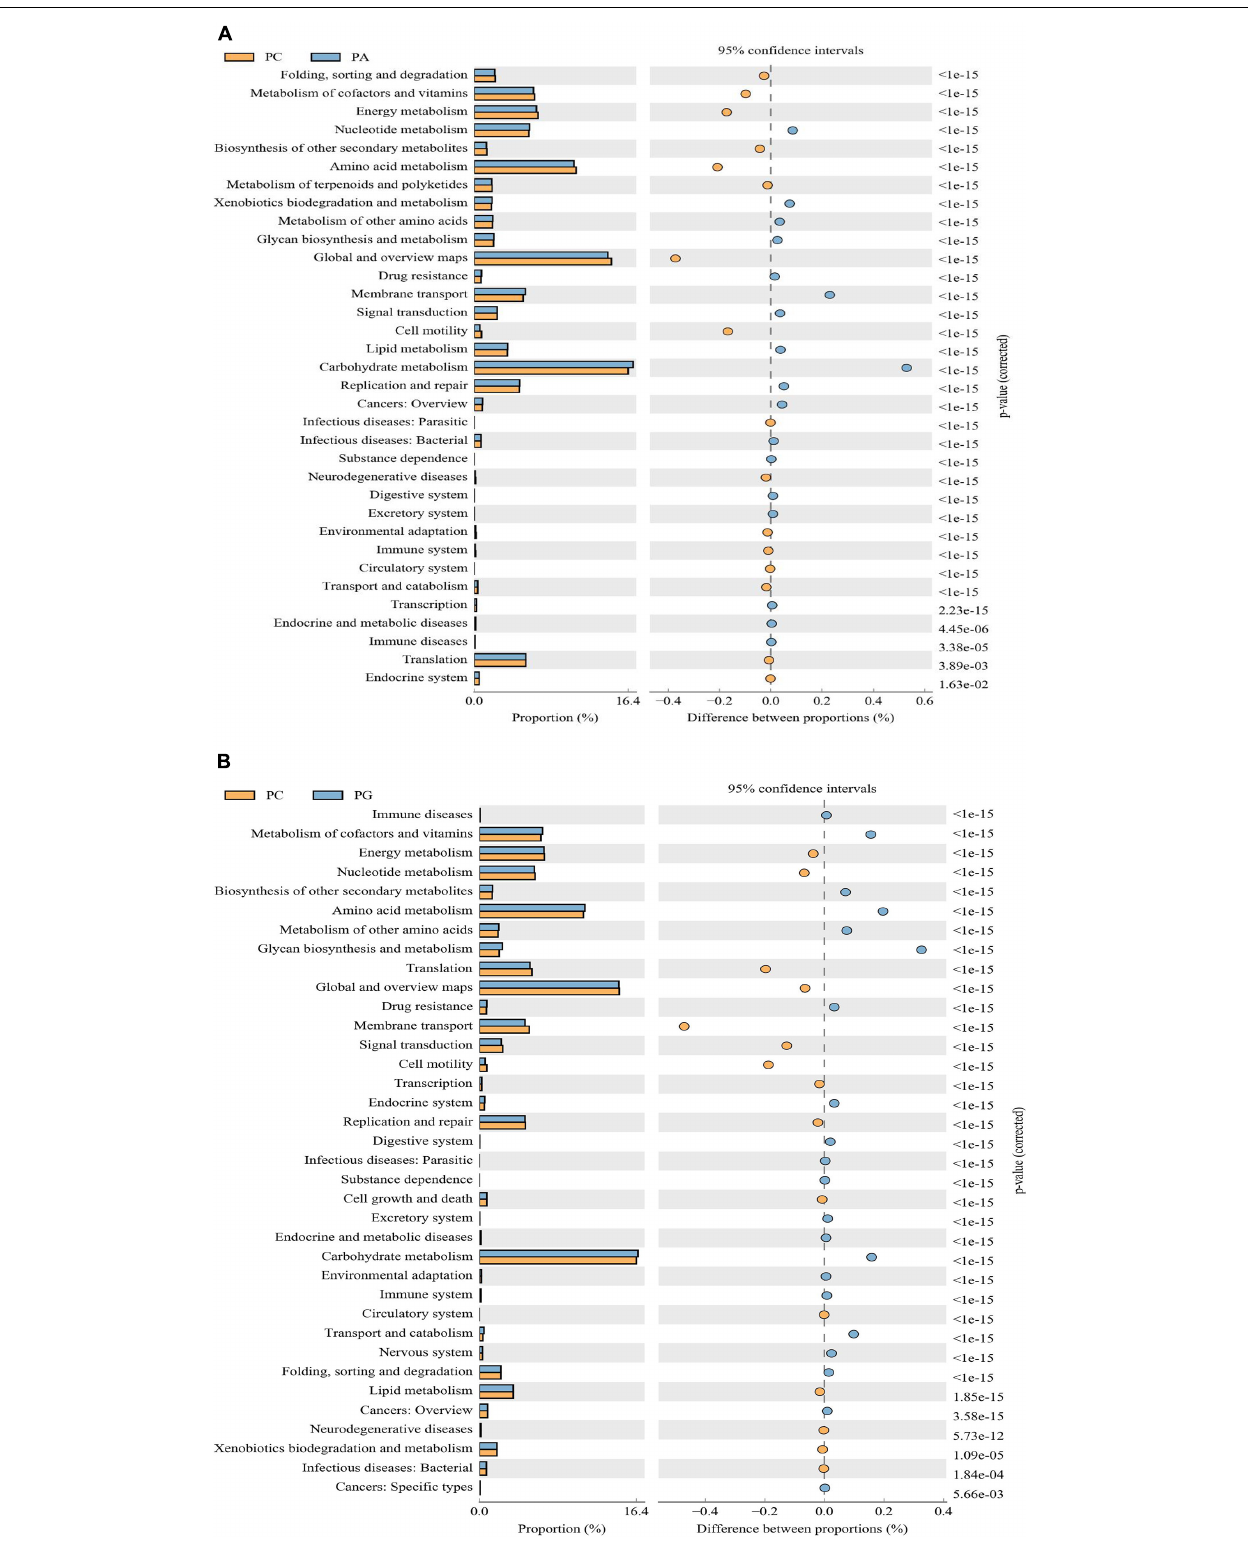
Frontiers in Microbiology |